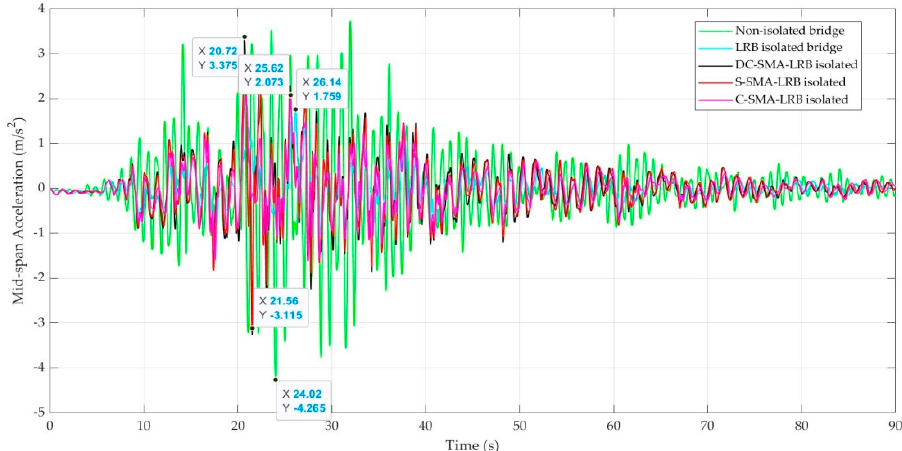
Figure 14. Time history curves of the mid-span acceleration under synthetic#3 of the RSN8161 record.